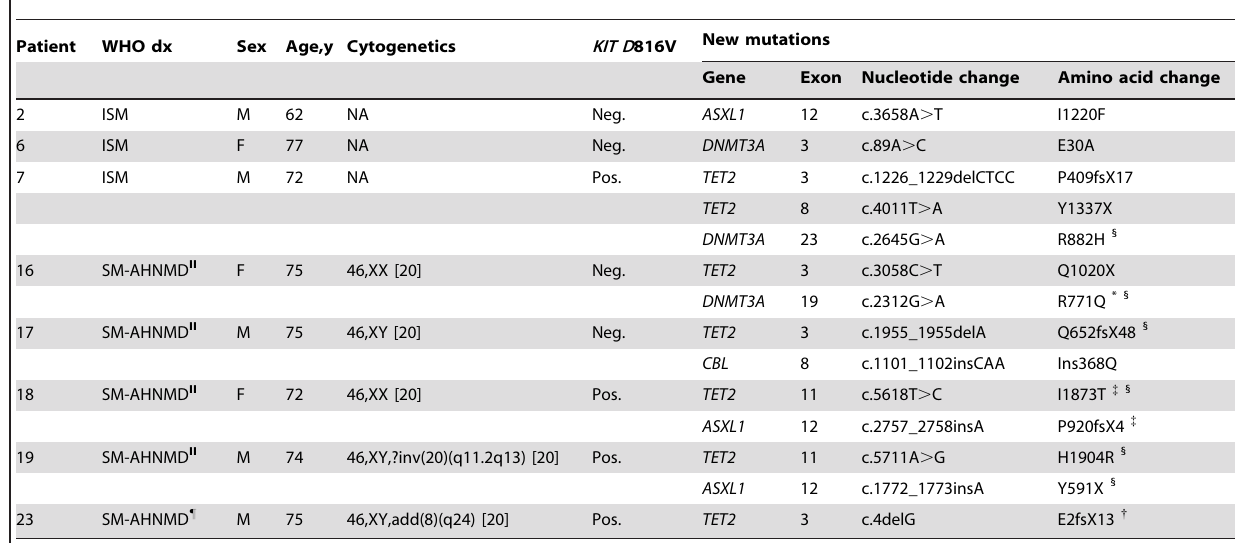
Table 3. Characteristics of patients carrying TET2 , DNMT3A , ASXL1 and CBL family mutation.